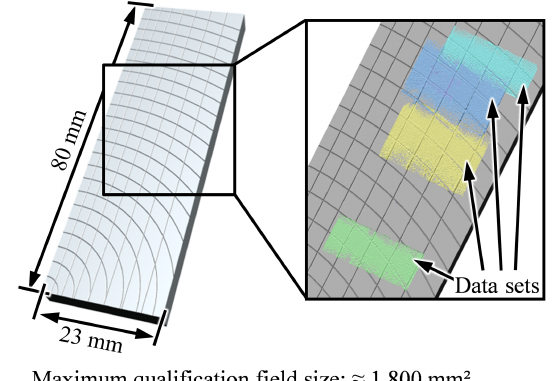
Figure 4. Automated (A) measuring procedure by using transfor- mation